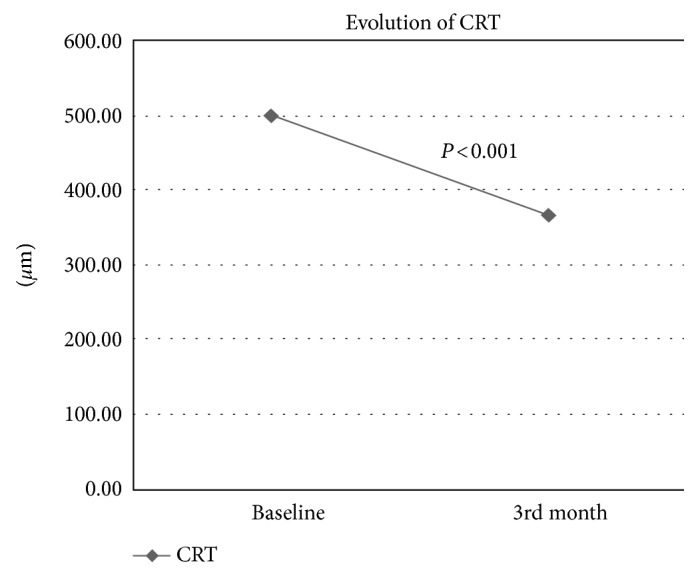
Evolution of CRT.